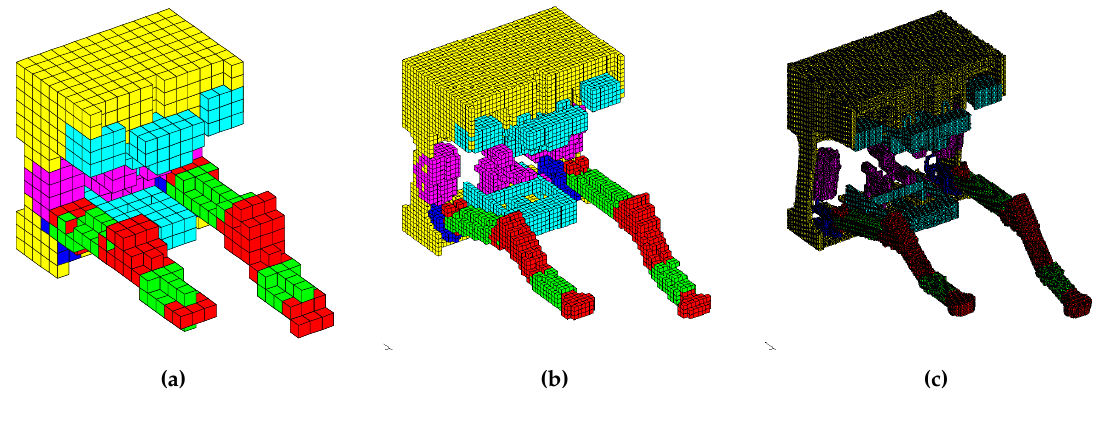
Figure 6. MRE ROV modelled with voxels of different size: ( a ) 100 mm; ( b ) 33 mm; and ( c ) 10